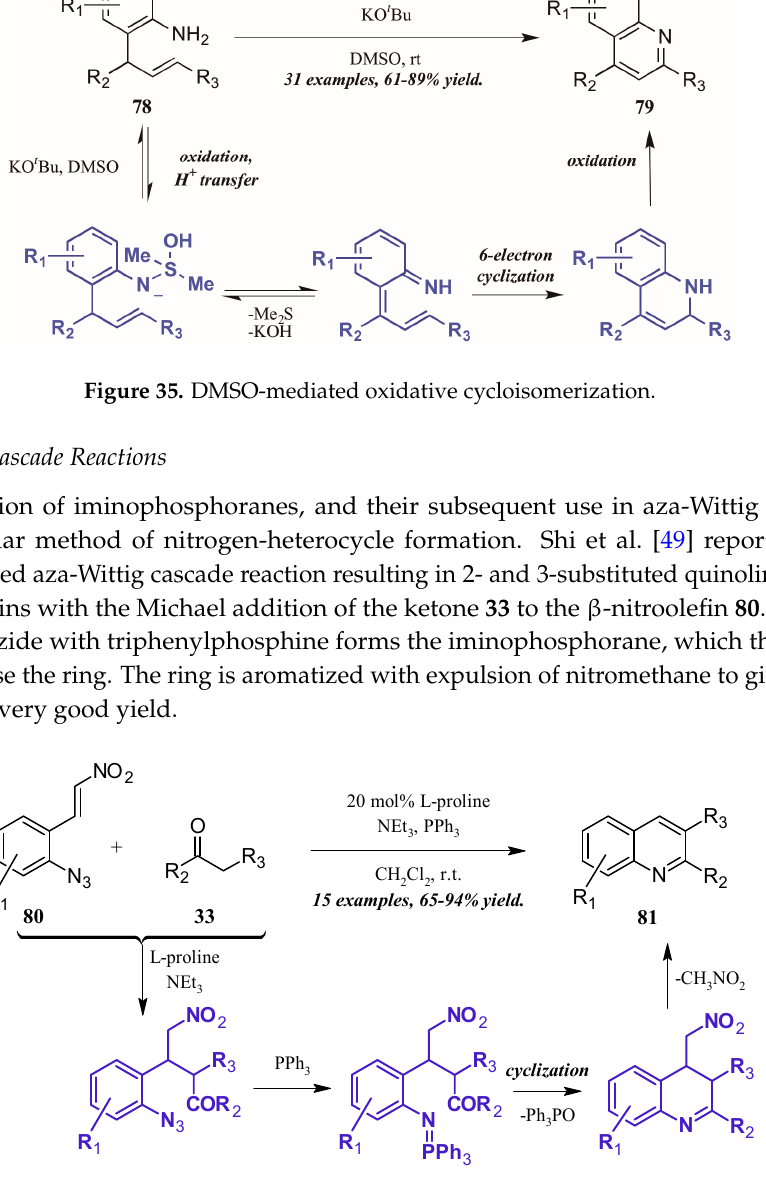
Figure 36. Base-catalyzed aza-Wittig cyclization of quinoines.